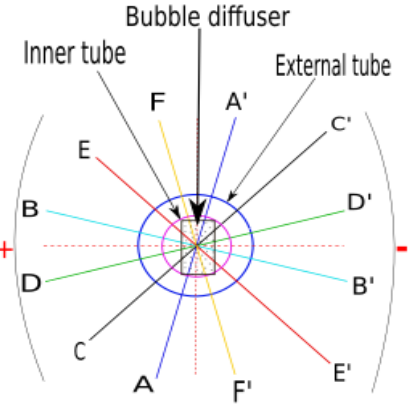
Figure 8. Schematic representation of the radial measurement axes by the optical